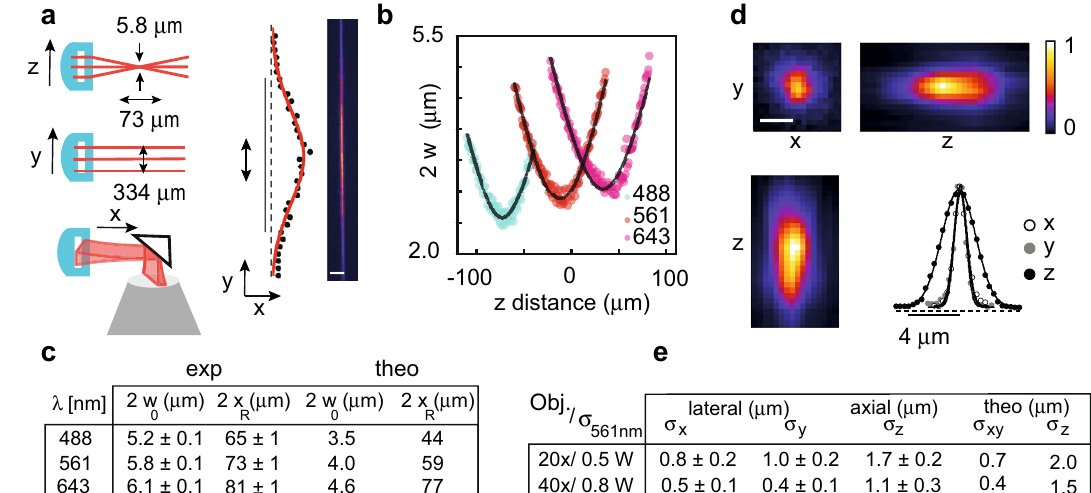
Figure 2. A simplistic light-sheet microscope with sub-cellular resolution. ( a – c ) Characterization of the light- sheet parameters. ( a ) The light-sheet propagates along the x-axis as an elliptical Gaussian beam characterized by its thickness 2 w 0 , its Rayleigh length x R and its width 2 w y . The parameters were determined by imaging the transversal illumination profiles. ( b ). Parameters w 0 and x R are quantified by fitting a hyperbolic function (black line) to the measurements w ( z ) . The light-sheet thickness remains well below 10 microns, allowing optical sectioning of the sample. Multicolour imaging is possible as the Rayleigh length is comparable to the chromatic shift ( c ). ( d – e ) Quantification of the 3D resolution. The PSF was measured by imaging gel-embedded fluorescent beads. ( e ) Values displayed in the table are mean 1 / e radius ( σ x , y , z ) for profiles along the three axes with standard